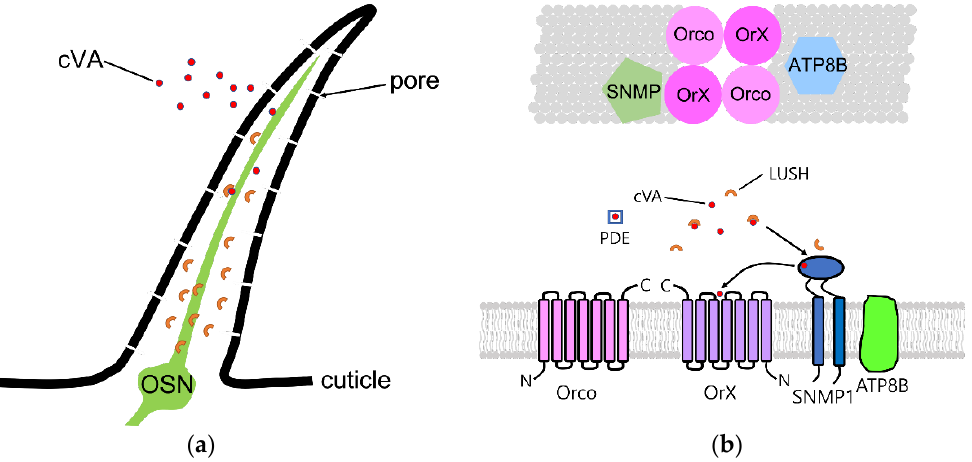
Figure 2. Model of cVA detection mechanism in aT1 neurons. ( a ) Cartoon of aT1 trichoid sensillum. aT1 sensilla have numerous pores in the cuticle layer and house a single olfactory receptor neuron (OSN) dendrite. LUSH (cup-shaped structures in sensillum lymph) binds cVA and deliver it to neuronal receptors. ( b ) Receptor complex in aT1 sensillum. In this sensillum, tetrameric receptor complex is composed of Or67d pheromone receptor, the coreceptor Orco. SNMP1, a CD36-related sensory neuron membrane protein, is also required in dendritic membrane. ATP8B, a lipid flippase, is also important for normal Orco-dependent responses [63,64].